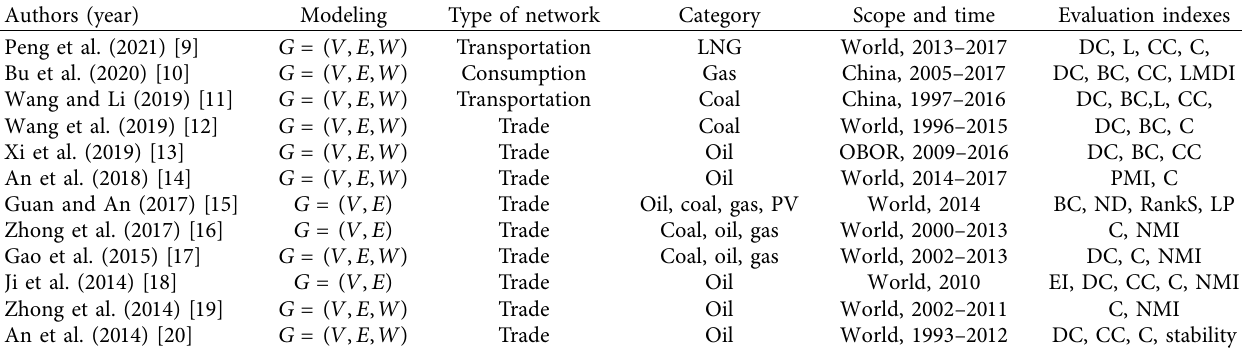
Table 1: List of fossil energy trade network studies in recent